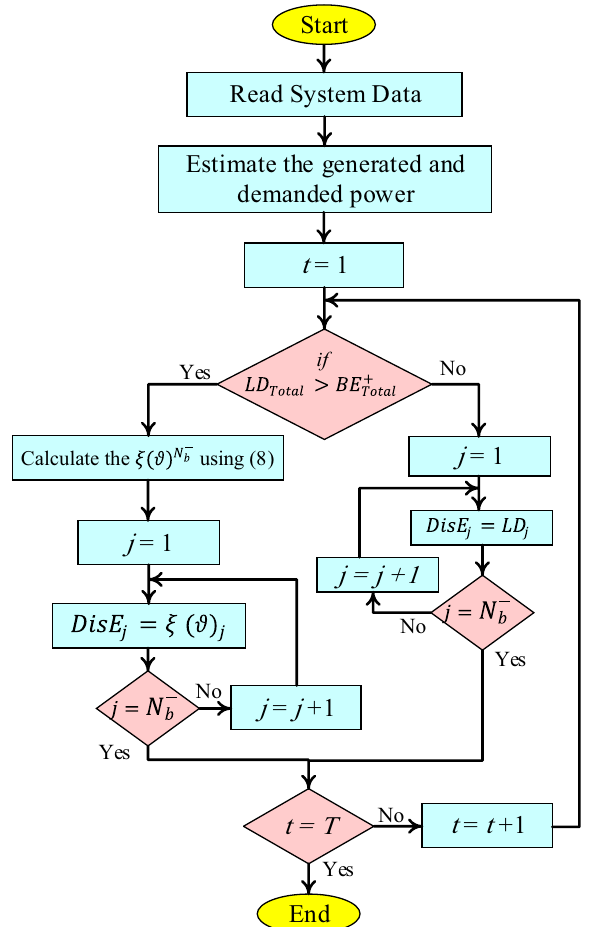
Figure 2. The flowchart for the proposed EMS algorithm in